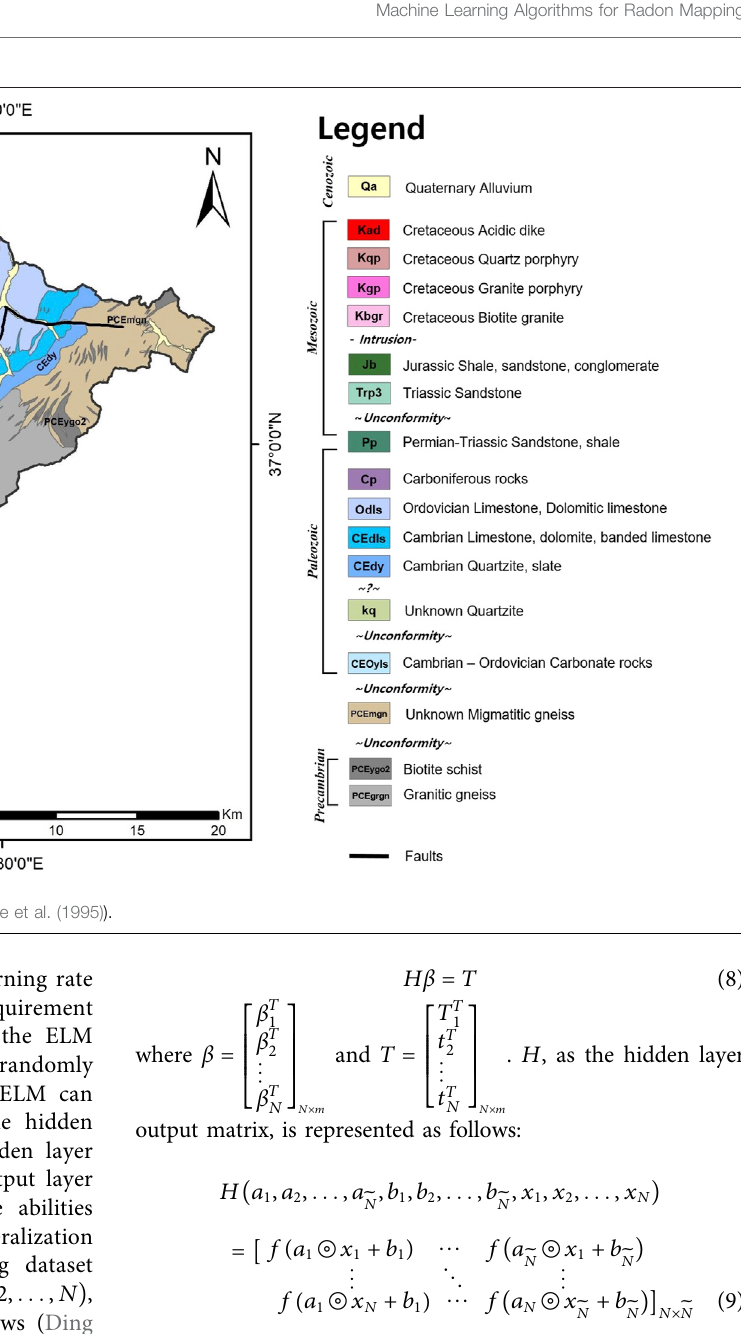
Frontiers in Environmental Science |